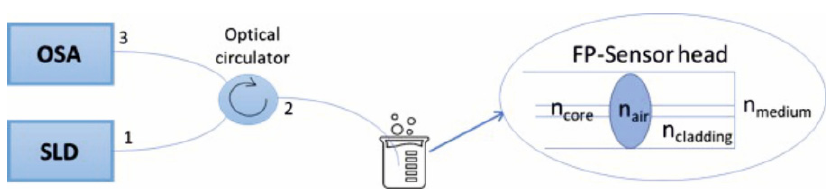
Figure 4. Interrogation setup for RI sensing. OSA - optical spectrum analyzer; SLD - superluminescent diode.